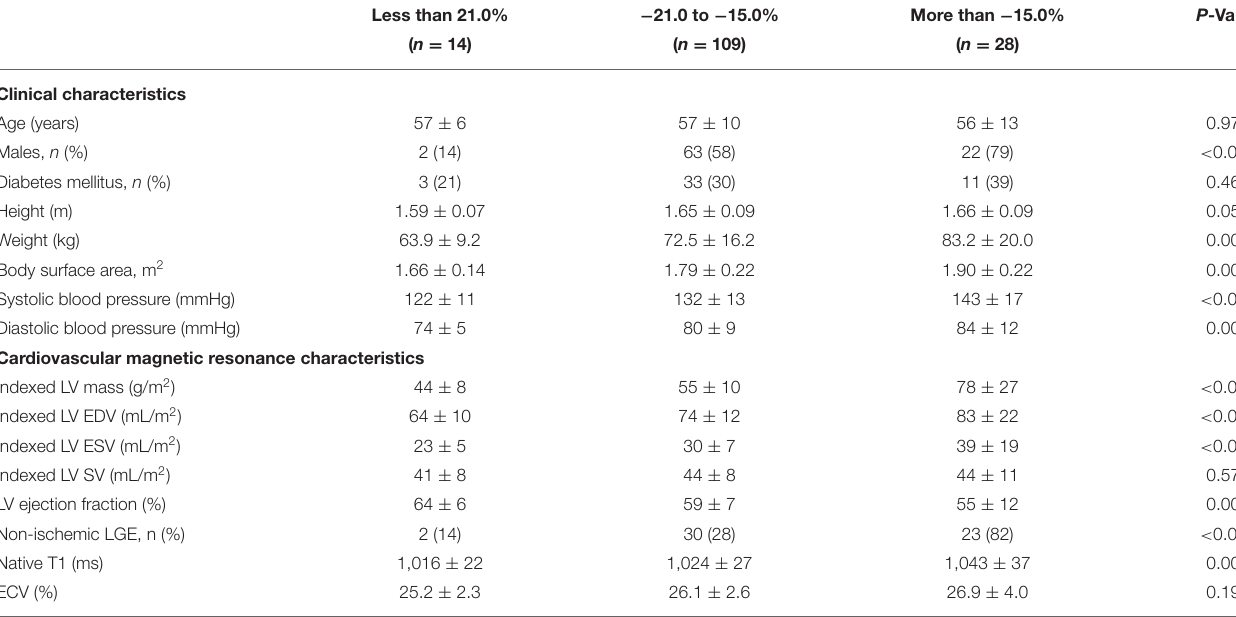
TABLE 2 | Characteristics of patients in the derivation cohort, stratified by global longitudinal strain. Less than 21.0% − 21.0 to − 15.0% More than − 15.0% P